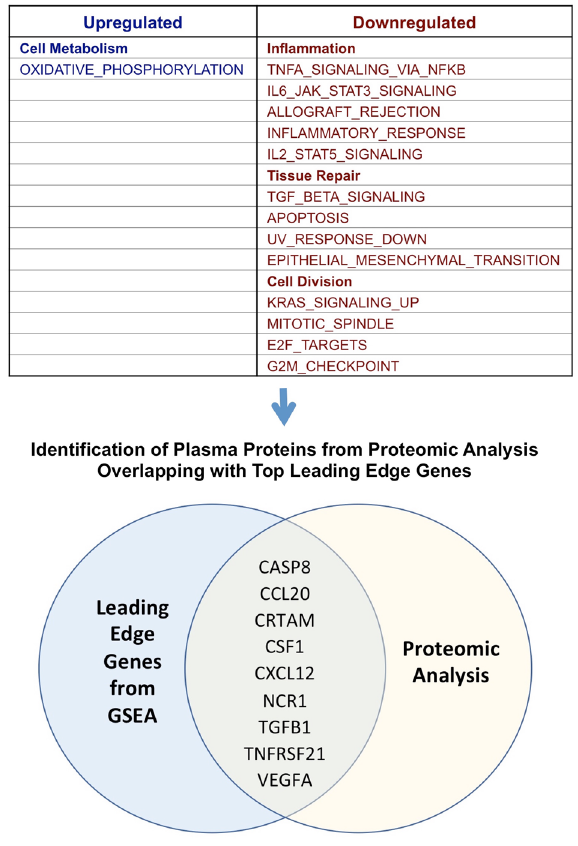
Figure 1. Analysis Schema. A total of 9 plasma proteins were examined, corresponding to top leading edge genes within hepatic gene pathways differentially modulated by tesamorelin. Abbreviations: CASP8, caspase 8; CCL20, C–C motif chemokine ligand 20; CRTAM, cytotoxic and regulatory T-cell molecule; CSF1, macrophage colony stimulating factor 1; CXCL12, C-X-C motif chemokine ligand 12; NCR1, natural cytotoxicity triggering receptor 1; TGFB1, transforming growth factor beta 1; TNFRSF21, tumor necrosis factor receptor superfamily member 21; VEGFA, vascular endothelial growth factor